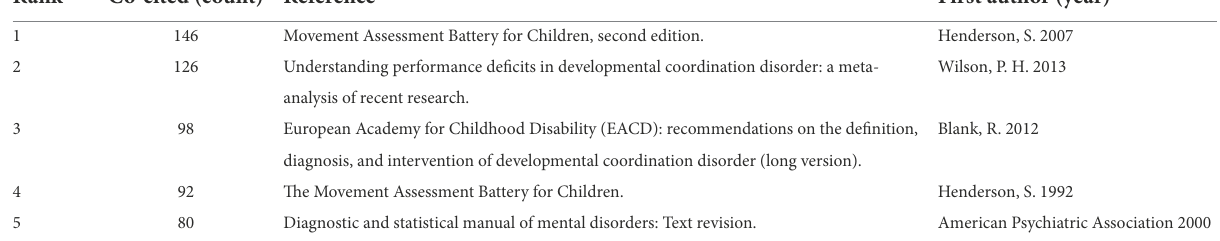
TABLE 5 Top five co-cited